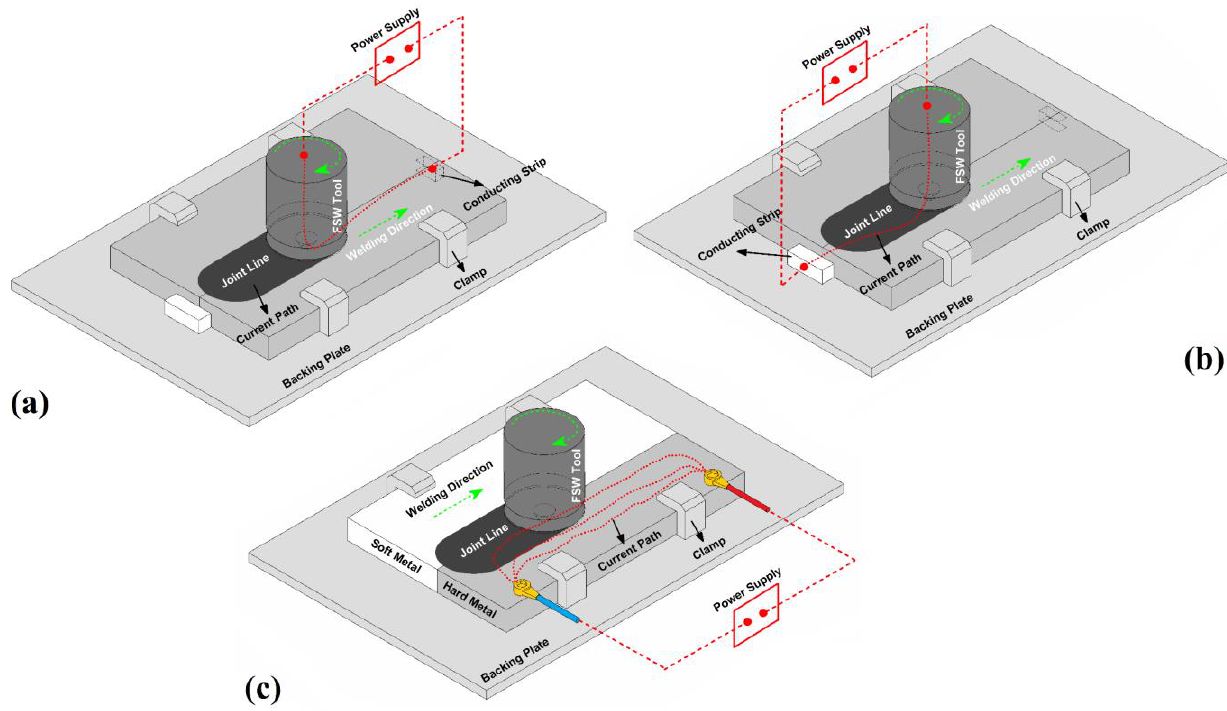
Figure 1. EA-FSW in ( a ) preheating, ( b ) heat treatment, and ( c ) combination models. The classification in EA-FSW is related to the electrical current circuit. A power supply is used in the middle of the electrical line to create an electrical current flow into the joint line, on the side of the current attached to the FSW tool (usually positive side) and another side attached to a conductive strip. If the conductive strip is placed in front of the